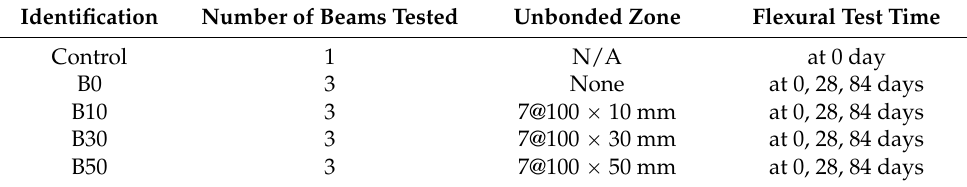
Table 3. Beam specimens and test parameters.